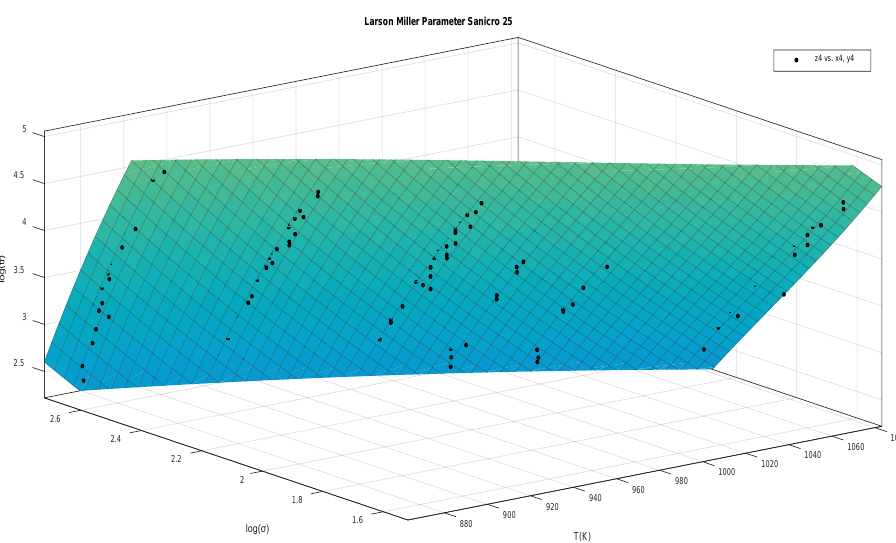
Figure A15. HR6W Larson-Miller parameter surface fit.